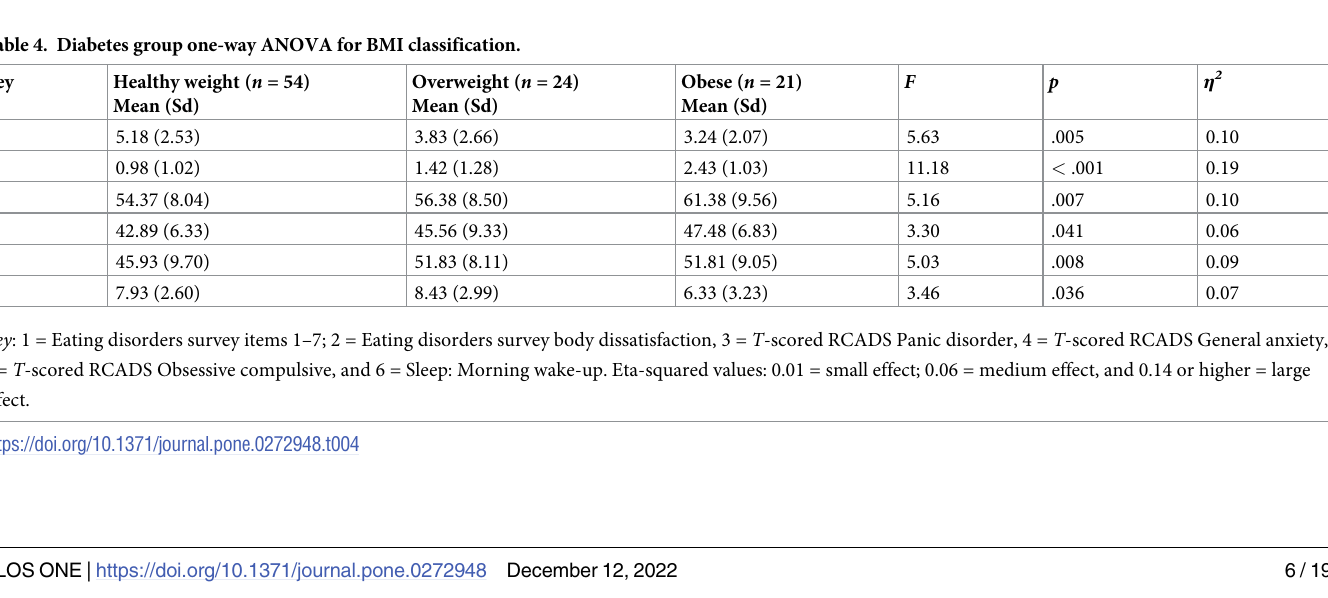
BMI classifications for diabetes group. The BMI scores for the diabetes group were clas- sified into four main categories: underweight; healthy weight, overweight, and obese. The underweight group was excluded from the analysis ( n = 1). Children whose BMI was classified as obese scored higher on eating disorders survey body dissatisfaction; and T -scored RCADS panic disorder, general anxiety, and sleep awake earlier. Overweight children scored higher on T -scored RCADS obsessive compulsive. Interestingly, children whose BMI was classified as healthy weight were found to be scoring higher on the eating disorder survey items 1–7 than those who were either overweight or obese (see Table 4). Mental health and wellbeing variables for the diabetes group. A Pearson’s r bivariate correlation was conducted to identify the relations between children’s mental health and well- being scores (see Table 5). A number of significant negative correlations were found to exist between the child’s wellbeing and T- scored RCADS social phobia, T -scored RCADS depres- scores. This demonstrates that the elevated scores for (non-clinical) measures of social phobia,